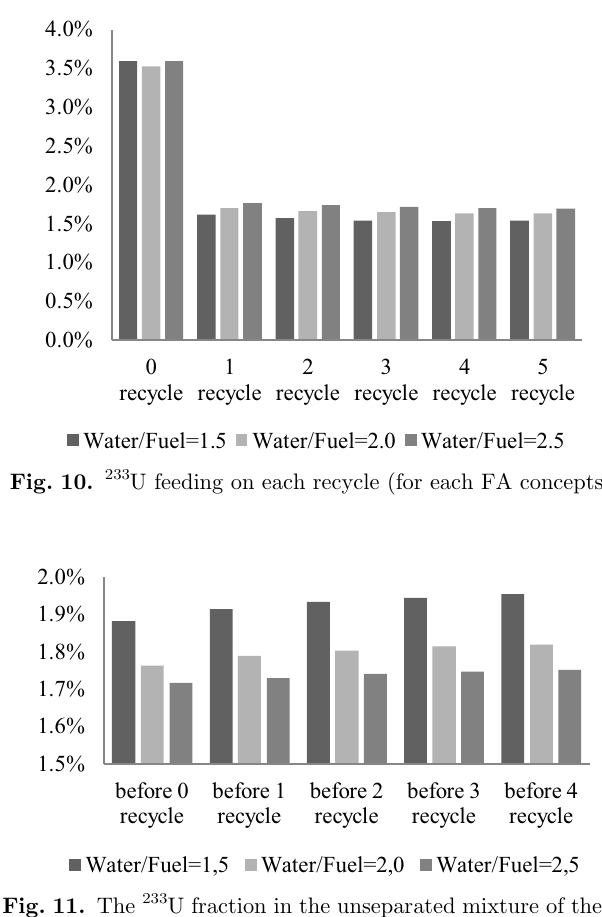
Fig. 11. The 233 U fraction in the unseparated mixture of the U and Pu isotopes, which is required for REMIX(Th)-fuel fabrication (for each FA